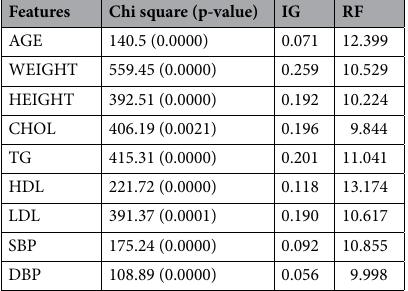
Table 3. Feature selection